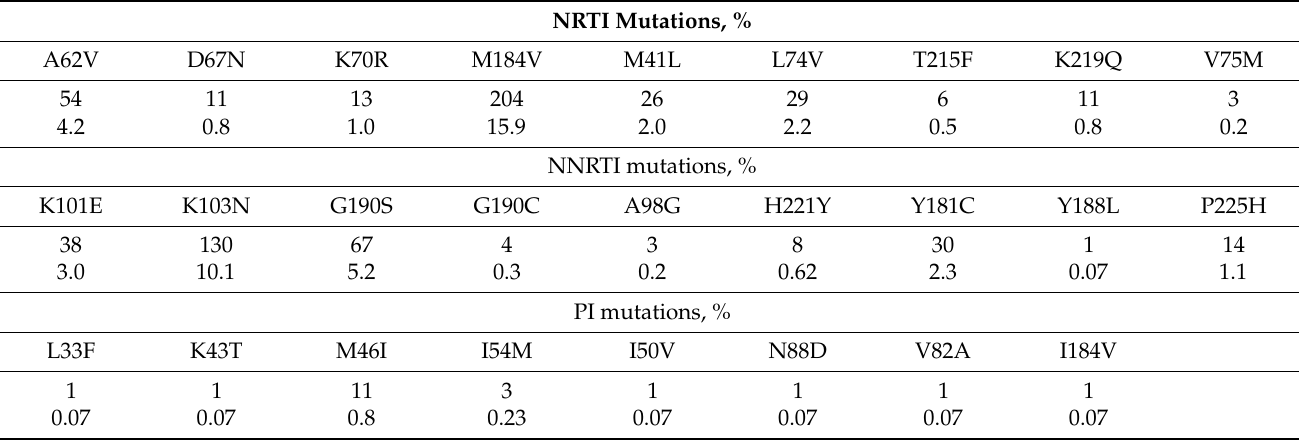
Table 3. The rate of the main drug resistance mutations in 2016–2018